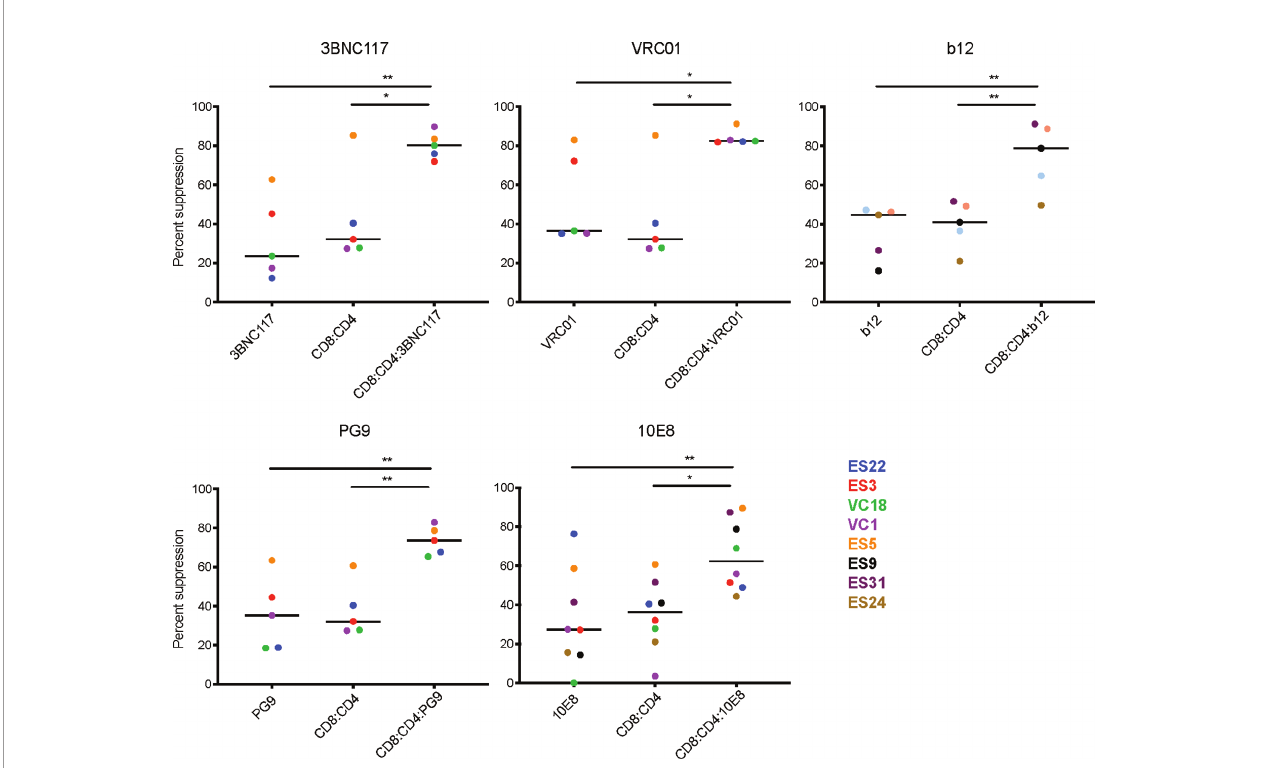
FIGURE 2 | Combination of bNAbs and autologous CD8 T cells enhances heterologous suppression. CD4 T cells from 6 ES and 2 VC were infected with GFP- NL4.3deltaEnv_X4 with and without bNAb IC50 and then co-cultured with multiple CD8:CD4 ratios. The E:T which resulted in 60% or less of suppression was used to compare the levels of suppression in bNAb only well, CD8 only and CD8+bNAb wells. The combination of any CD8 IC60 +bNAb IC50 lead to enhanced suppression of HIV infection in all assays. Each data point displays the average of three technical replicates performed for each condition. The line indicates the median, each colored point represents data from one subject, and the value is calculated by averaging three technical replicates within the experiment. Statistical analysis was performed using a 1-way ANOVA with Tukey ’ s multiple comparison test, *p < 0.05 and **p <